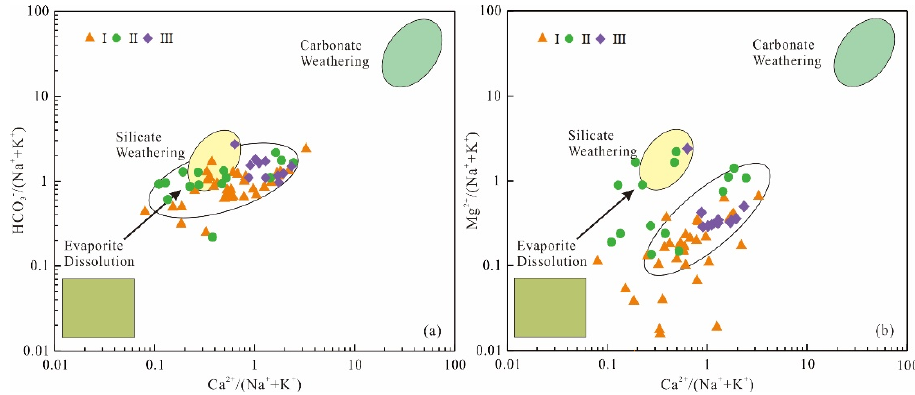
Figure 7. Source distribution of samples by composition ratios. ( a ) HCO 3 − /(Na + +K + ) vs. Ca 2+ /(Na + +K + ), ( b ) Mg 2+ /(Na + +K + ) vs. Ca 2+ /(Na + +K + ).